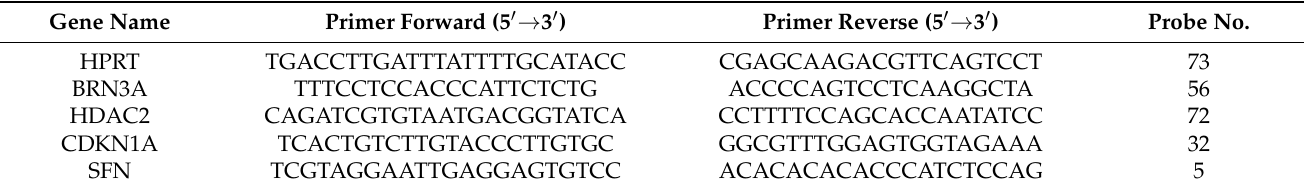
Table 1. Primers for mRNA quantification by